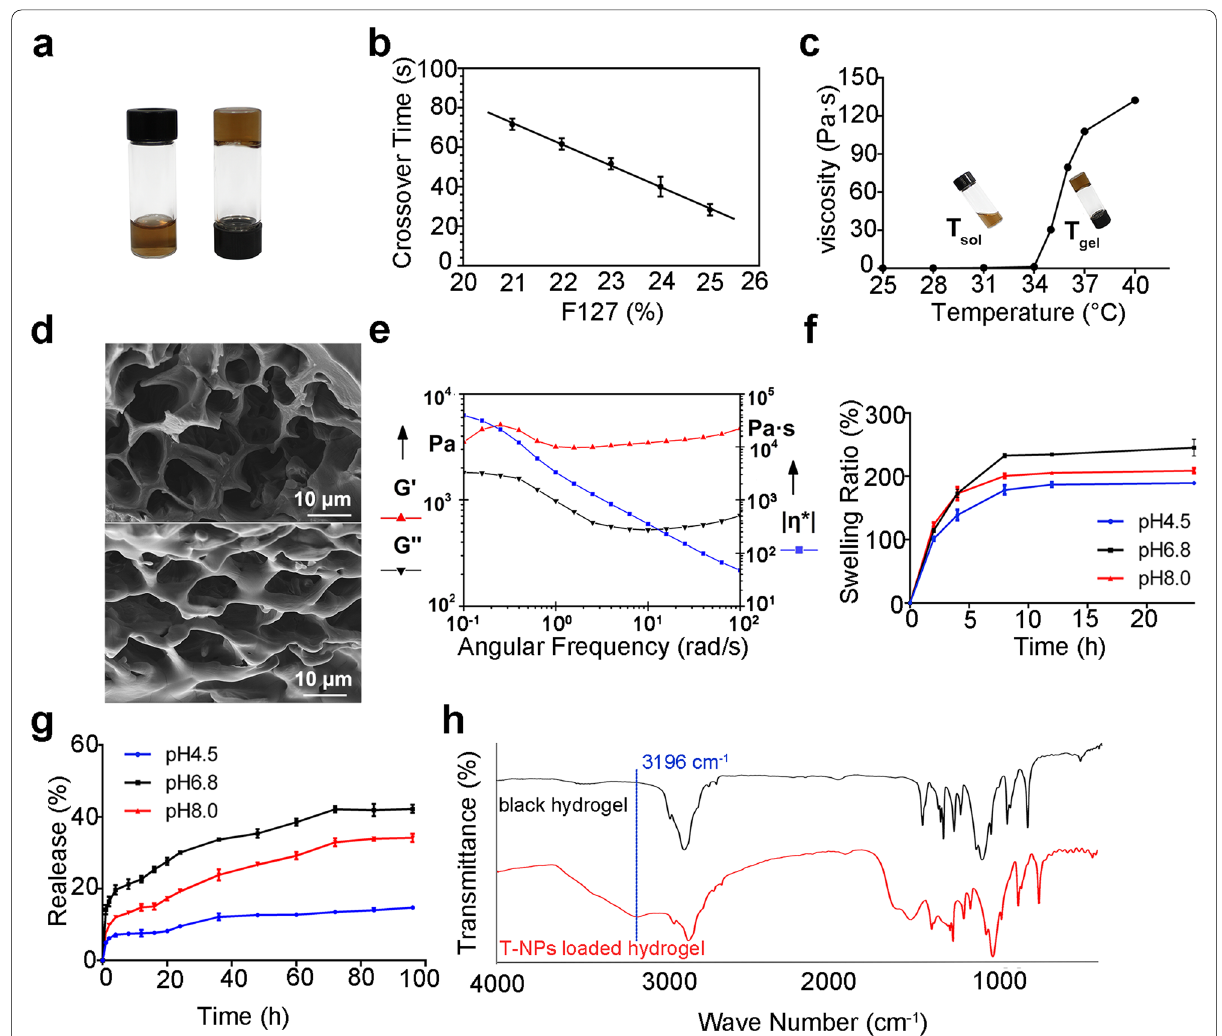
Fig. 4 Characterization and property of hydrogel loaded with T-NPs. a Photograph of T-NPs loaded hydrogel in sol and gel state respectively at room temperature (left) and at 37.0 °C (Right). b The influence of F127 content on gelation time. c Viscosity of T-NPs-loaded hydrogel in different temperature. d SEM image of blank hydrogel (up) and T-NPs-loaded hydrogel (down). e Rheology analysis of T-NPs loaded hydrogel. f Swelling test of T-NPs loaded hydrogel in artificial saliva with different pH values. g The accumulated release rate of T-NPs loaded hydrogel in artificial saliva with different pH values on 96 h. h Infrared spectrum absorption of blank hydrogel (black) and T-NPs loaded hydrogel